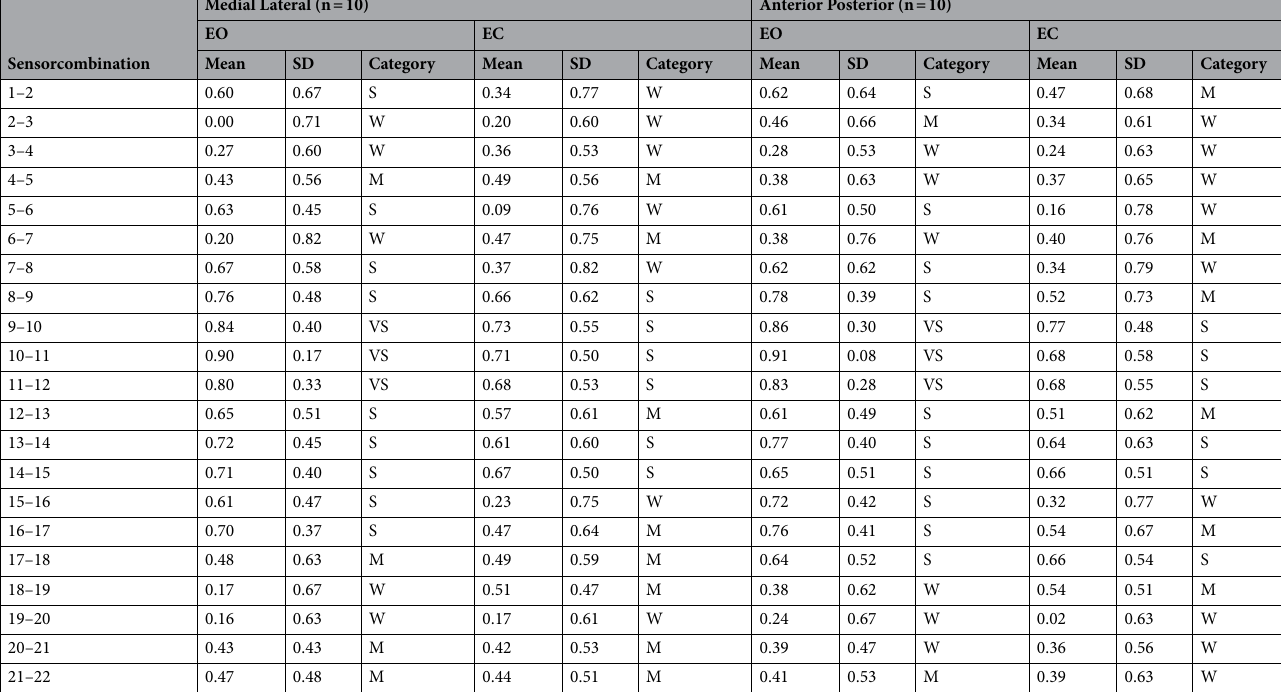
Table 1. Acceleration similarity between sensors (AAC). The mean acceleration similarity and category between each sensor are shown for each condition. AAC: average acceleration correlation, VS: very strong, S: strong, M: moderate, W: weak, SD: standard deviation, EO: eye-opening condition, EC: eye-closing